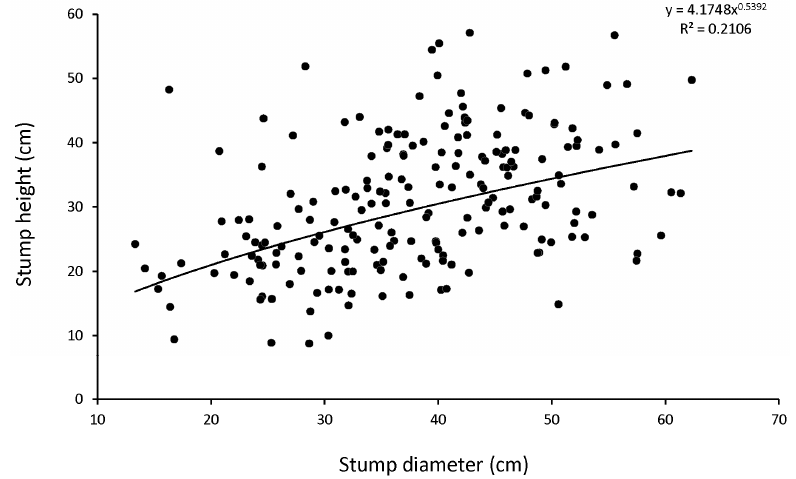
Figure 7. Relation between stump height and stump diameter.